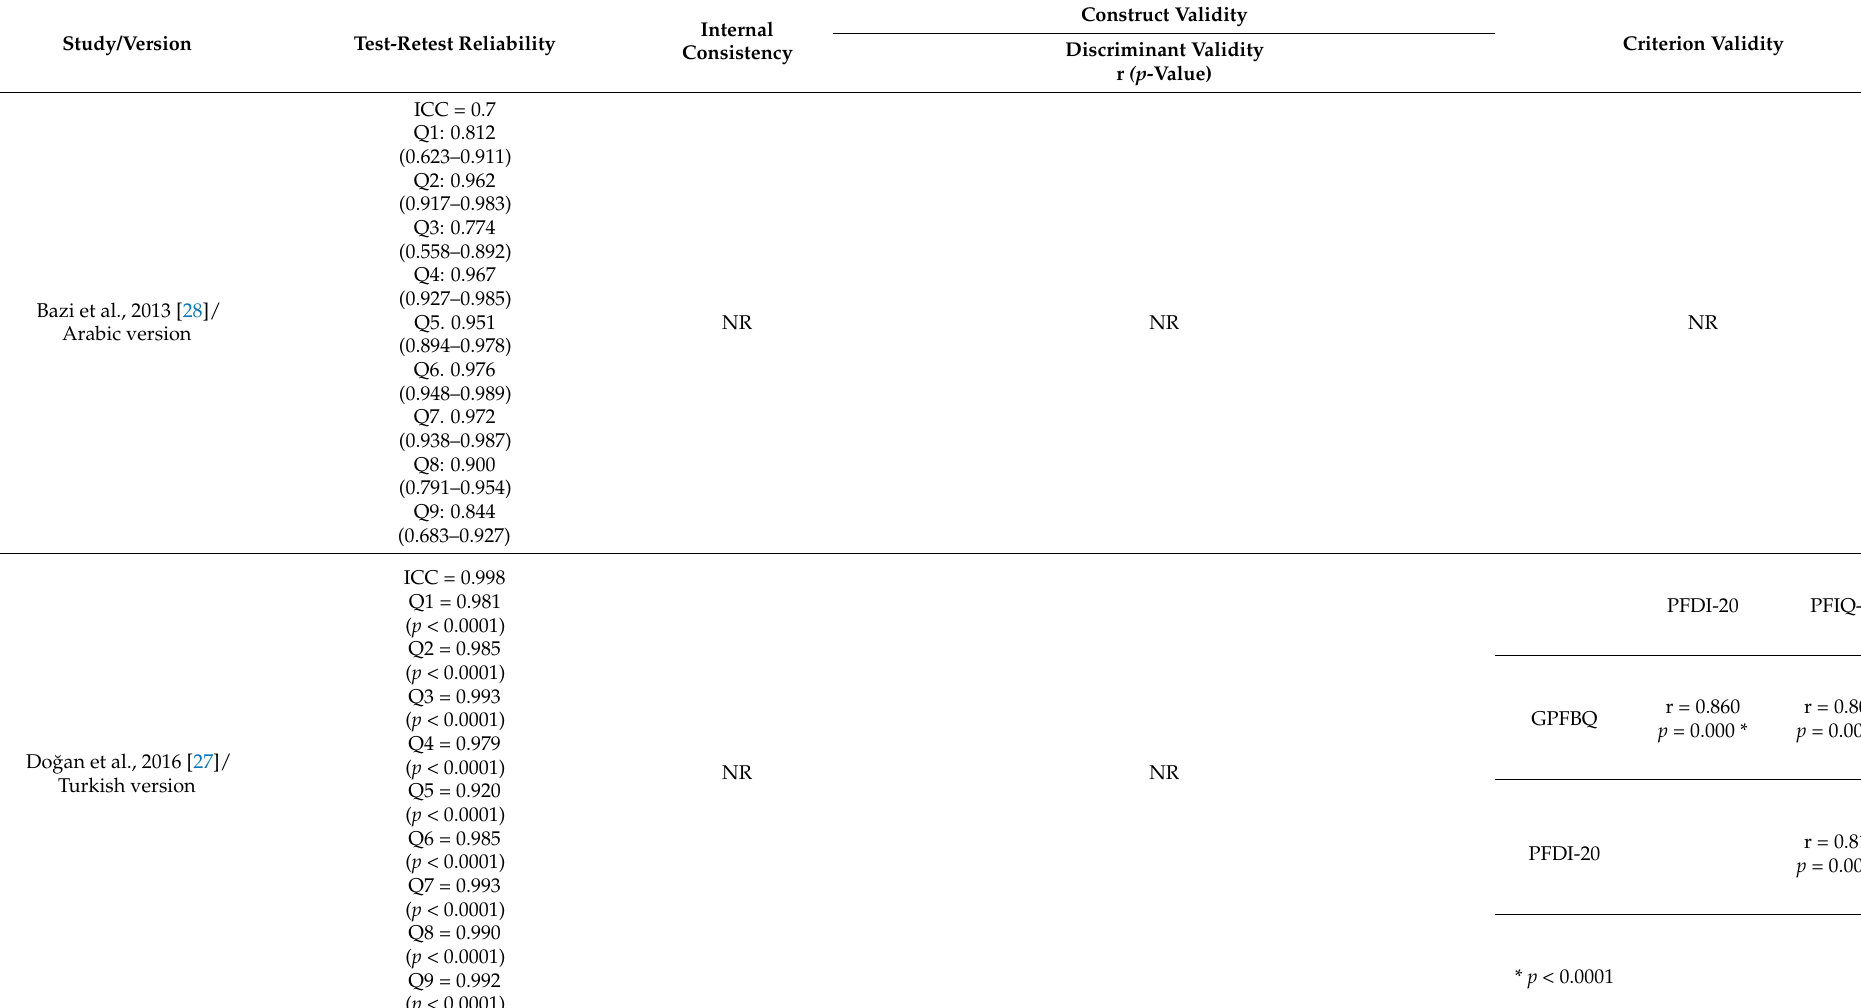
Table 2. Psychometrics properties of the